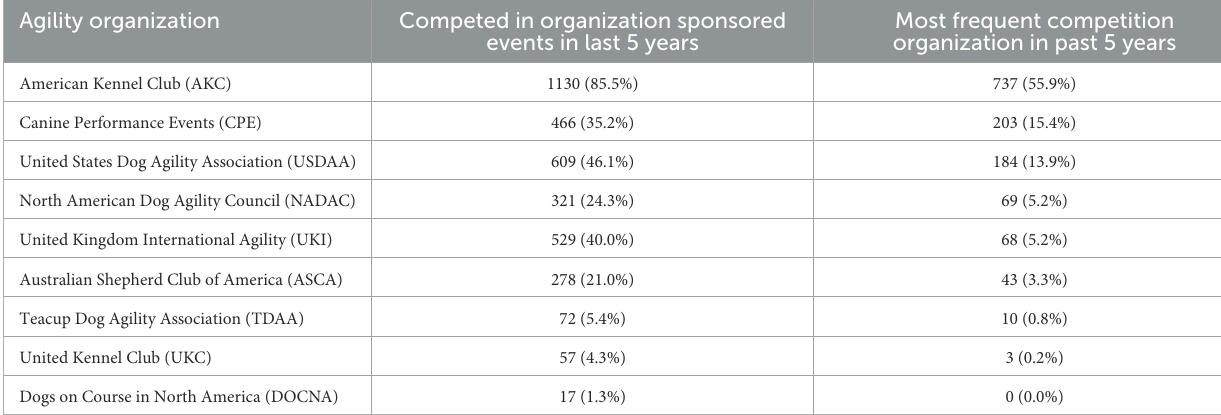
TABLE 2 Number (percent) of 1,322 respondents who indicated that they had competed in agility competitions sponsored by each major agility organization in the past 5 years and number (percent) of 1,319 respondents who indicated that the specified organization had sponsored the competitions in which they had competed most frequently in the past 5